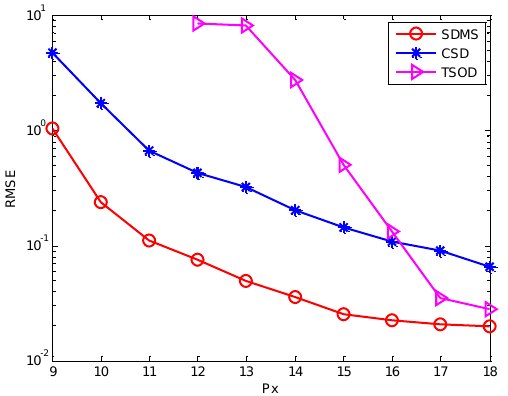
Figure 8. Performance versus the size of subarrays in the white noise